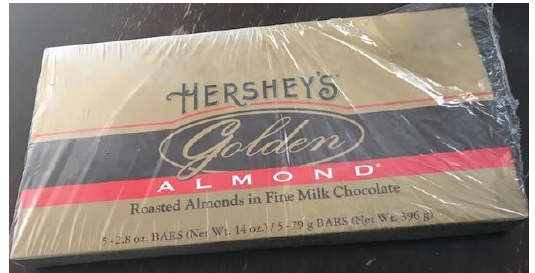
Figure 5. Child’s favorite snack (photograph submitted by family).